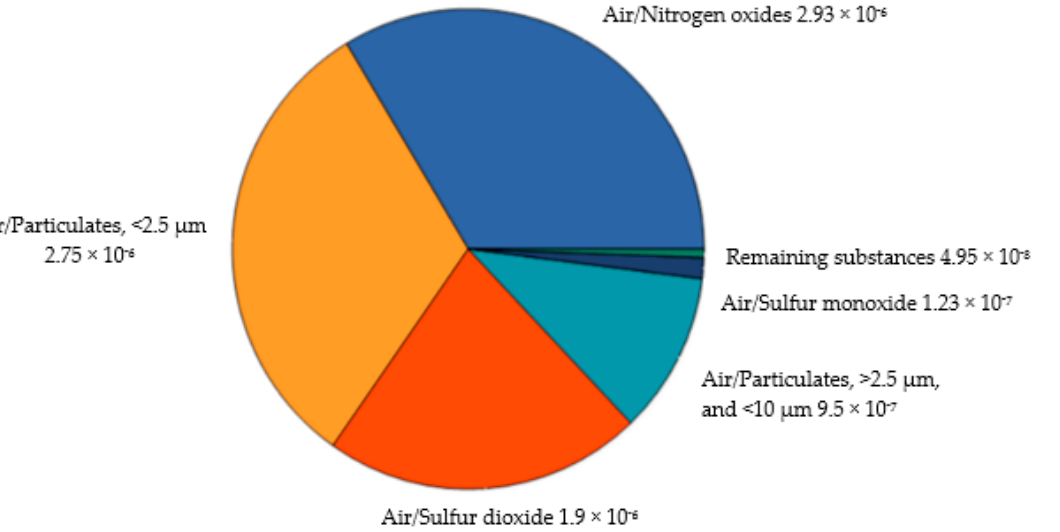
Figure 7. Elements released in the air contributed to the ‘Particulate matter formation’ impact category (damage assessment/excluding long-term emissions).